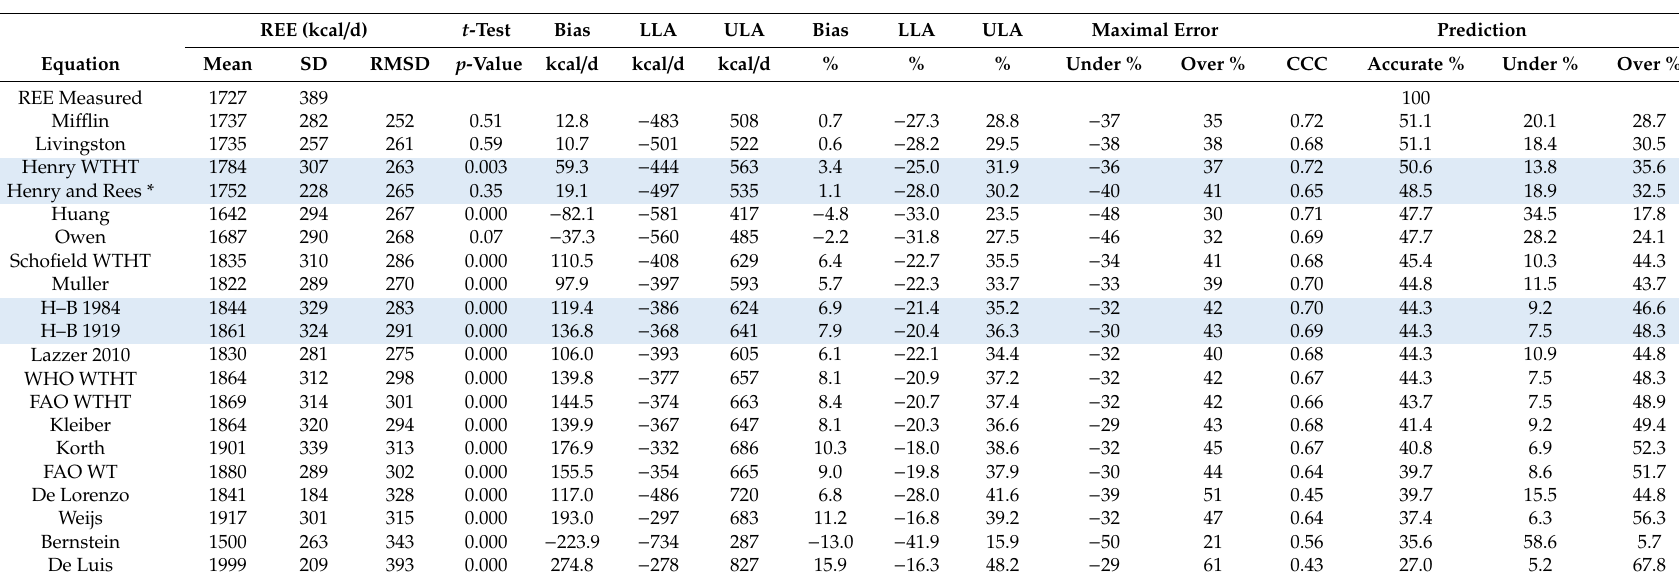
Table 3. Assessment of resting energy prediction equations in overweight and obese adults (88 men and 86 women) from the population of Gran